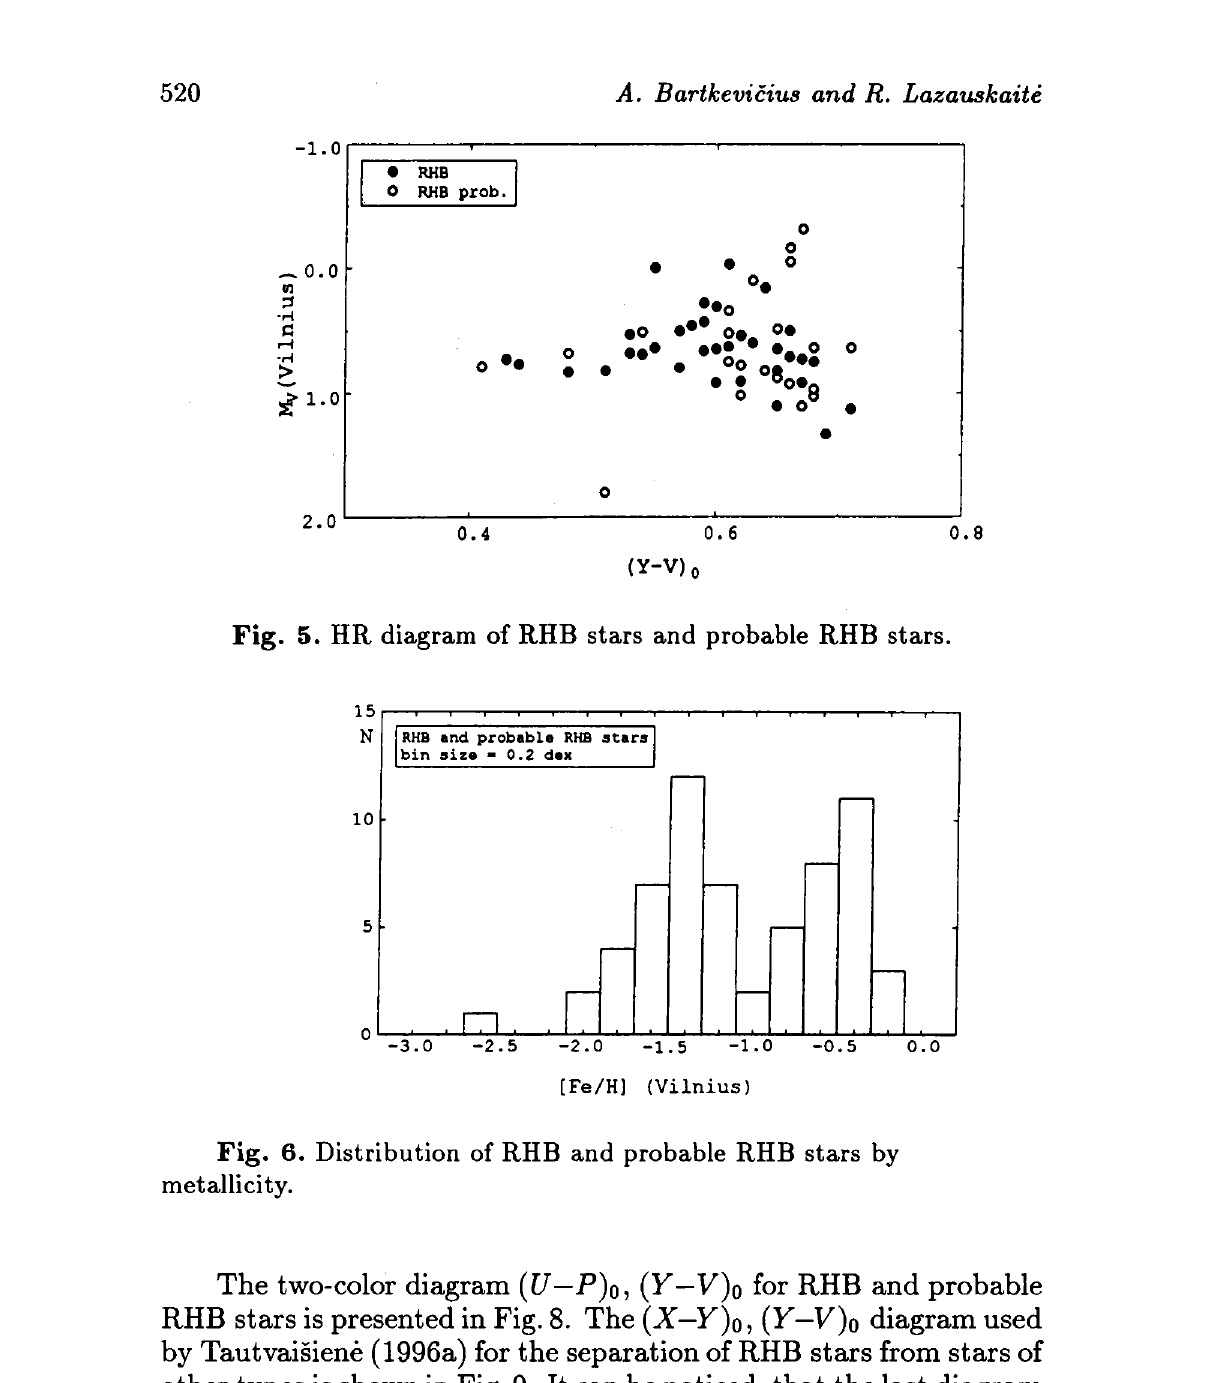
Fig. 6. Distribution of RHB and probable RHB stars by